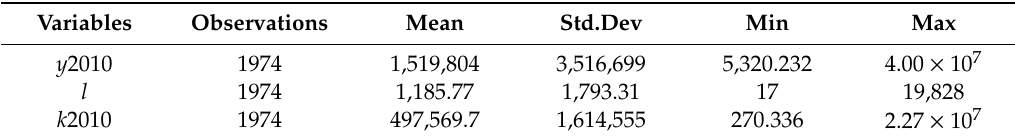
Table 2. Descriptive